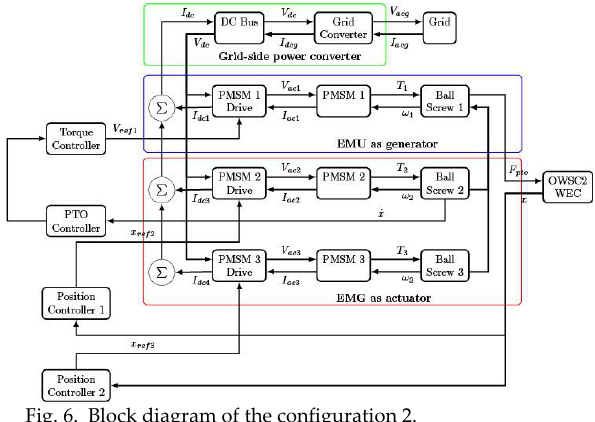
Fig. 6. Block diagram of the configuration 2.